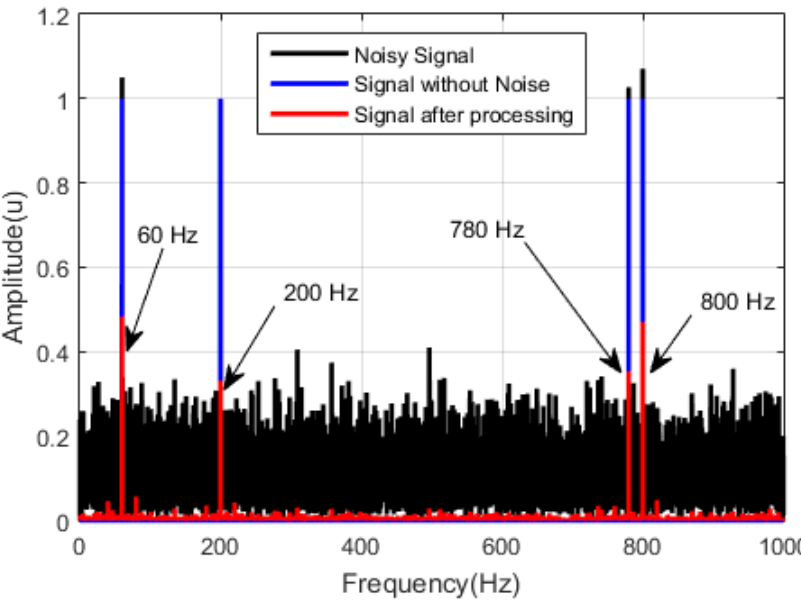
Figure 6. The spectrum of the original signal (blue), the spectrum of the noisy signal (black), and the spectrum obtained after applying our algorithm for noise reduction without additional information of the input signal (red); 16,000 processed samples.